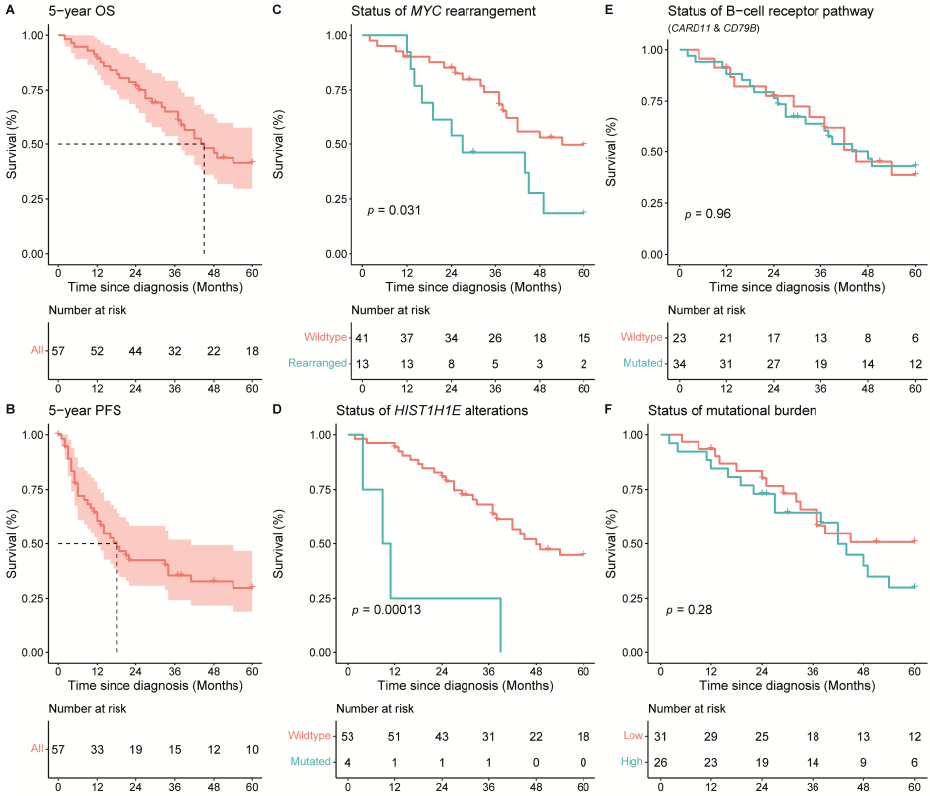
Figure 4. Overall survival (OS) and progression-free survival (PFS) of 57 patients with PCDLBCL-LT. The median OS of the cohort was 44 months. ( A ) The median PFS of the cohort was 17 months. ( B ) Rearrangements of MYC ( C ) and mutations in HIST1H1E ( D ) were associated with an inferior survival (Log rank; p = 0.001 and p = 0.00013, respectively). There were no statistically significant differences in OS for ( E ) patients with or without mutations in the B-cell receptor pathway ( CD79A/B or CARD11 ) and ( F ) patients with a high (>6 mutations) or low ( ≤ 6 mutations) mutational burden. In addition, all individual genetic abnormalities were analysed with a univariable cox- the risk of each mutated gene (Supplemental Table S1). This analysis demonstrated that only HIST1H1E, a linker histone H1 protein, had an increased hazard ratio for an inferior overall and disease-specific survival (HR: 6.52, CI-95: 2.163–19.659; adjusted p -value = 0.044; Figure 4D). Despite this statistically significant difference, the number of patients harbouring a HIST1H1E mutation is low ( n = 4) and this finding needs validation in an independent